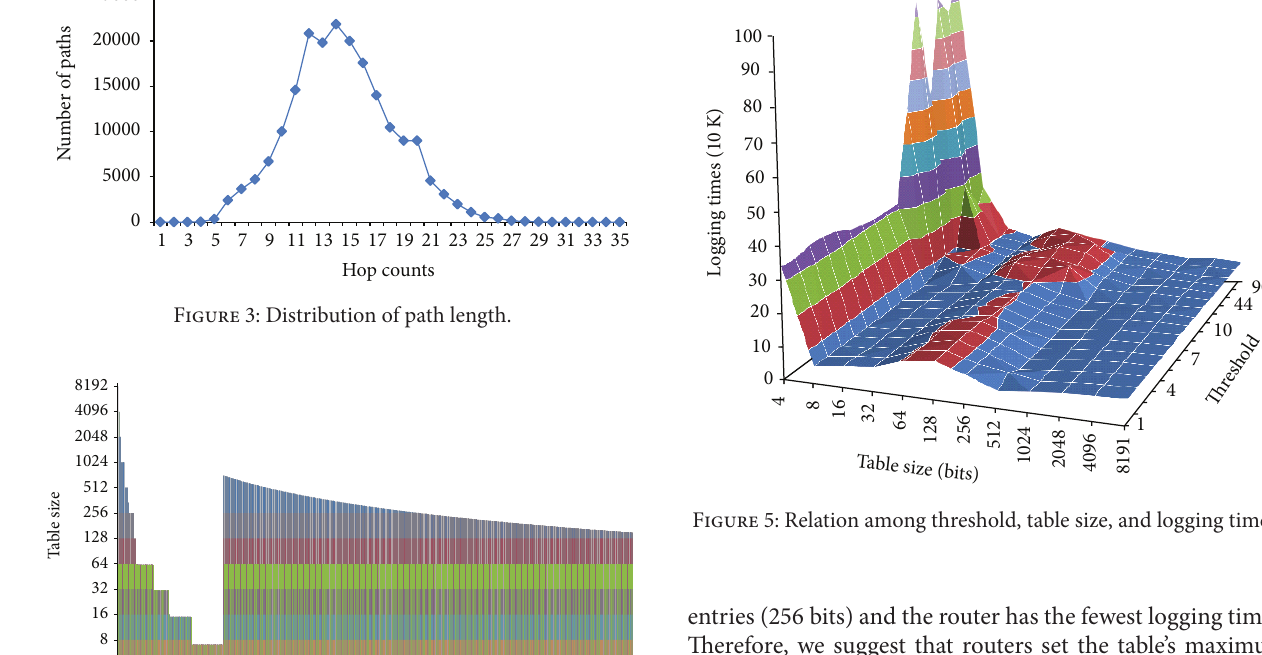
entries (256 bits) and the router has the fewest logging